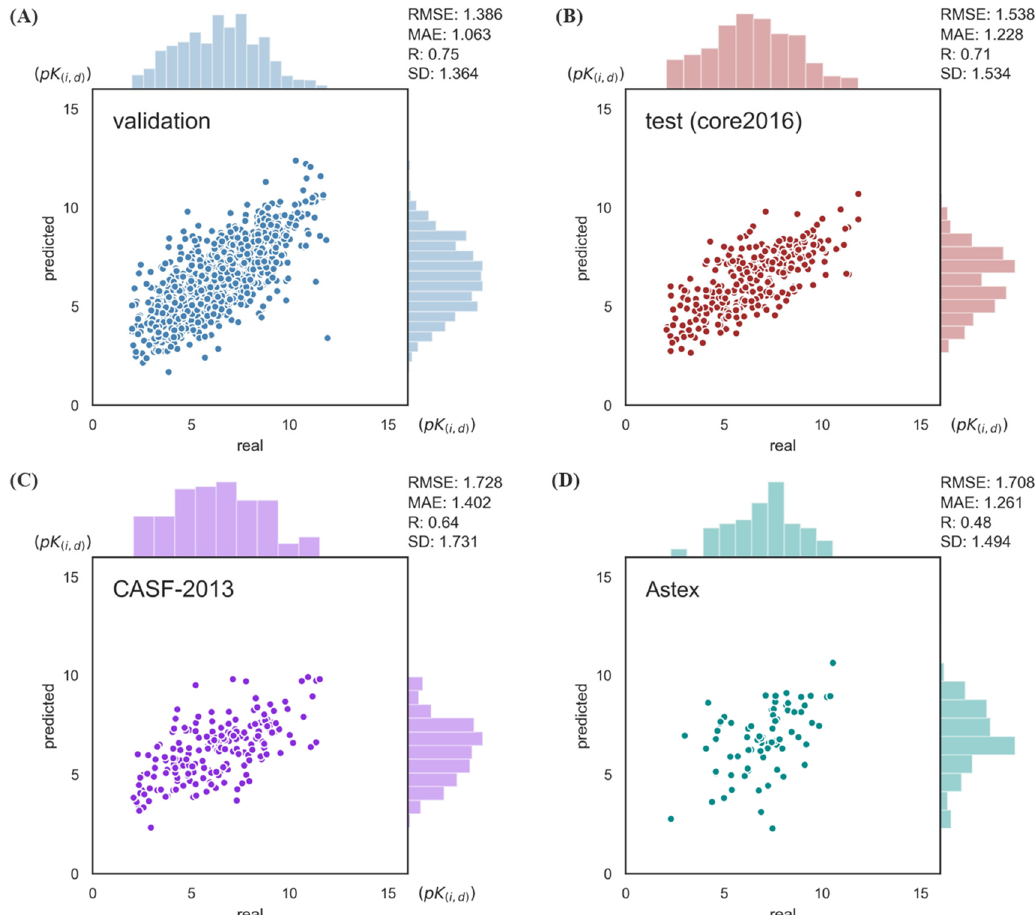
Figure 2. Model performance on the PDBbind v.2016 set and two independent sets. ( A ) PDBbind validation set. ( B ) PDBbind v.2016 core set. ( C ) CASF-2013. ( D ) Astex Diverse set. RMSE: root mean square error. MAE: mean absolute error. R: Pearson ′ s correlation coefficient R. SD: stand deviation.